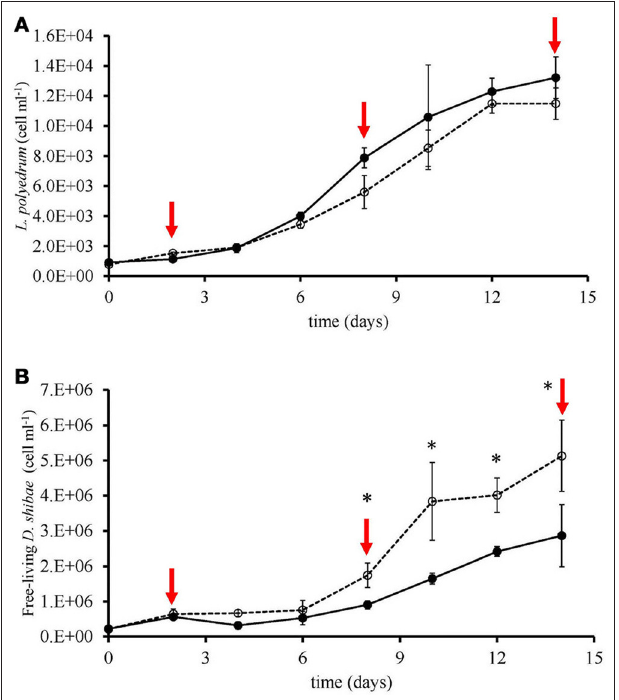
FIGURE 3 | Growth of L. polyedrum and D. shibae under V-R (-•-) and V-L (- -) cultures. (A) L. polyedrum abundance; red arrows denoted time-points of ◦ sampling. (B) Free-living D. shibae abundance. * p < 0.05 (ANOVA).